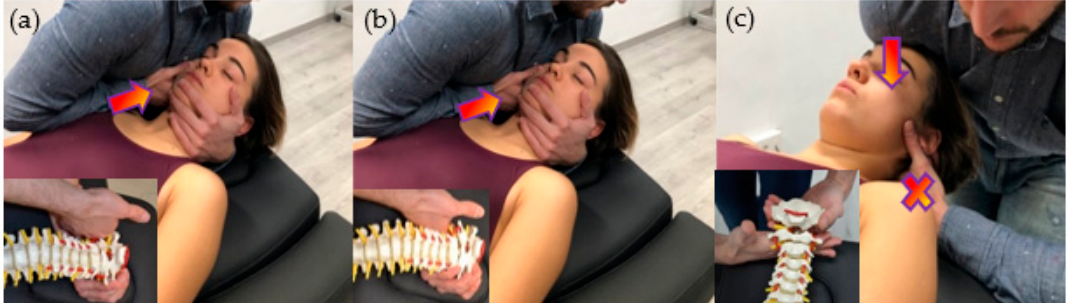
Figure 2. Manual therapy interventions. ( a ) C0-1 Traction Manipulation in the Resting Position. Patient was placed in supine with neck in a neutral position. The therapist gently cupped the patient’s chin with their hand while their arm was cradled around the head. The other hand placed the radial side of the index finger under the mastoid process and aligned the forearm in the line of drive pointing cranially. Then, the therapist applied a cranial thrust; ( b ) C2-3 Traction Manipu- lation in the Resting Position. The same handling procedure was performed, but the grip was relocated in C3 vertebrae; ( c ) C0-1 Dorsal Mobilization. Patient was positioned in supine, with neck in a neutral position. The therapist placed a hand dorsally at the level of the vertebral arch of C1 with the metacarpophalangeal and radial border of the index finger. The other hand was placed posteriorly under the occiput, with the shoulder positioned anteriorly on the patient’s forehead. The mobilization force was directed dorsally from the shoulder until the therapist felt a marked resistance, and then slightly more pressure was applied to perform a stretching mobilization.